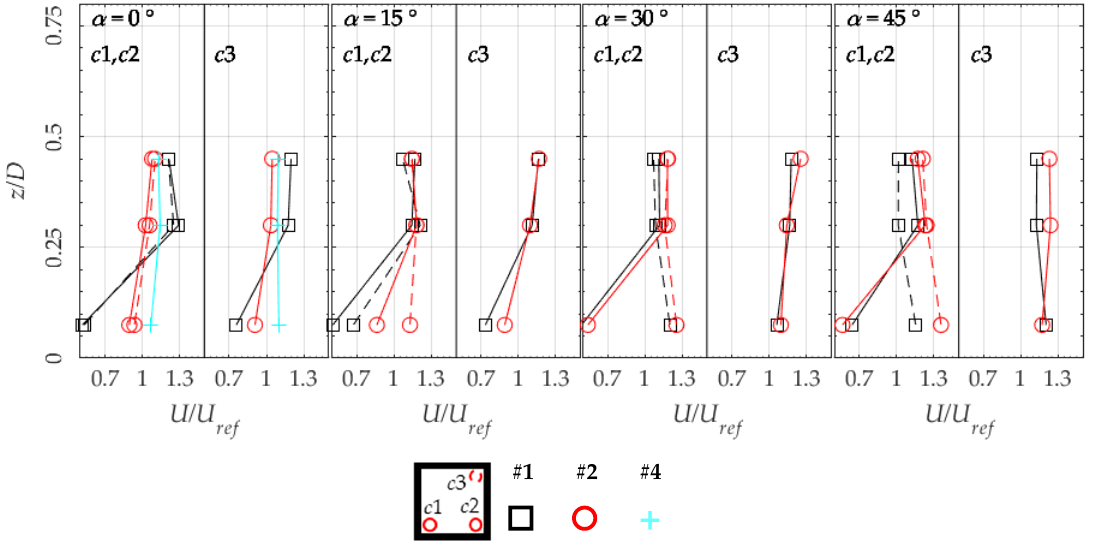
Figure 7. Mean wind speed at positions c 1 (dashed), c 2 and c 3 as indicated in the legend for configurations #1, #2, and #4, for the four wind directions. The plot on the left shows c 1 and c 2, while on the right c 3.